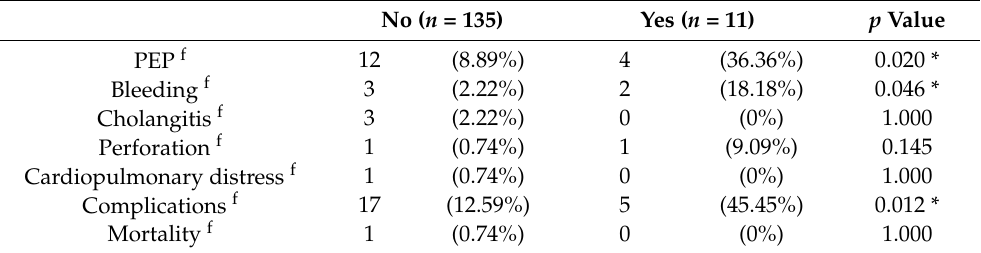
Table 4. Complications between patients with ESRD and patients without